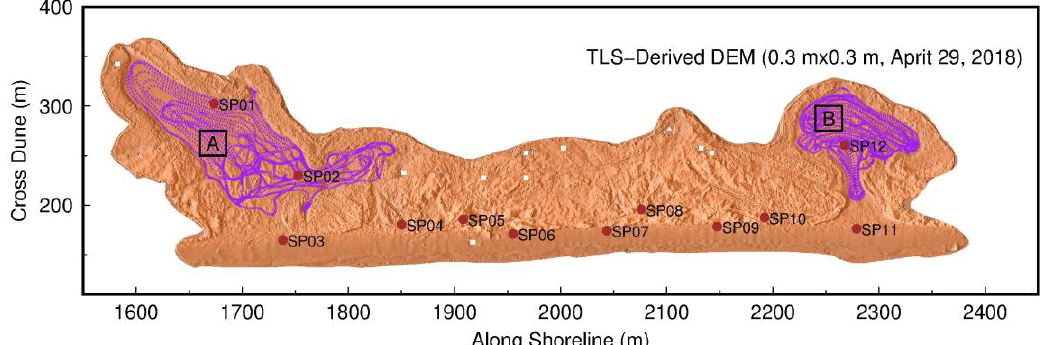
Figure 9. A hill-shaded digital elevation model (DEM) derived from the TLS datasets acquired on 29 April 2018, using the rapid surveying method. The location of the surveying area was marked in Figure 3b. The grid size was 0.3 m by 0.3 m. Red dots indicate 12 TLS scan positions. Purple dots represent kinematic GPS surveying points. Black rectangles indicate the areas that TLS and GPS points are compared in detail.